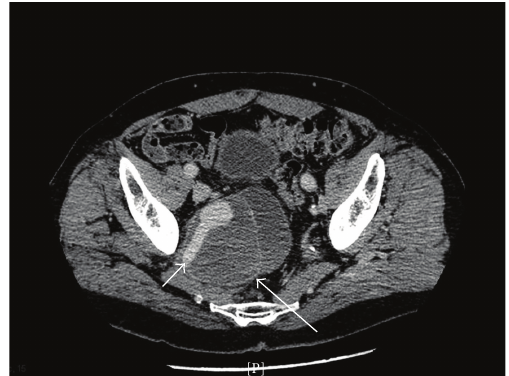
Figure 1: Right internal iliac artery pseudoaneurysm. A 7 × 9cm hematoma (large arrow, posterior edge) arises from the right internal iliac artery with 2.5 × 3.5 cm saccular contrast opacification (small arrow).